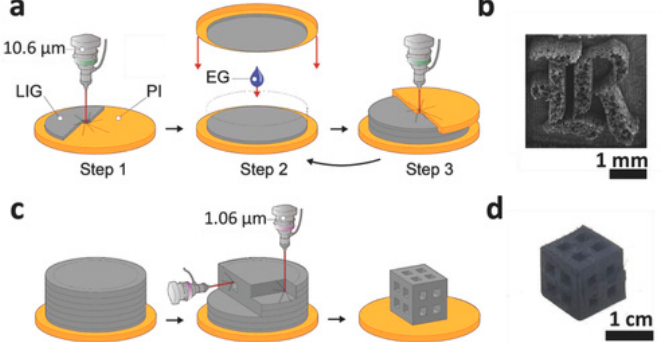
Figure 11. Laser-induced GFs are manufactured and processed: ( a ) Diagram of the LOM procedure; ( b ) milled LIG foam in a 3D “R” form. The LIG foam has a height of around 1 mm; ( c ) fiber laser milling process diagram; ( d ) LIG foam produced in three dimensions using a mix of LOM and fiber laser machining (adapted with permission from reference [37]).